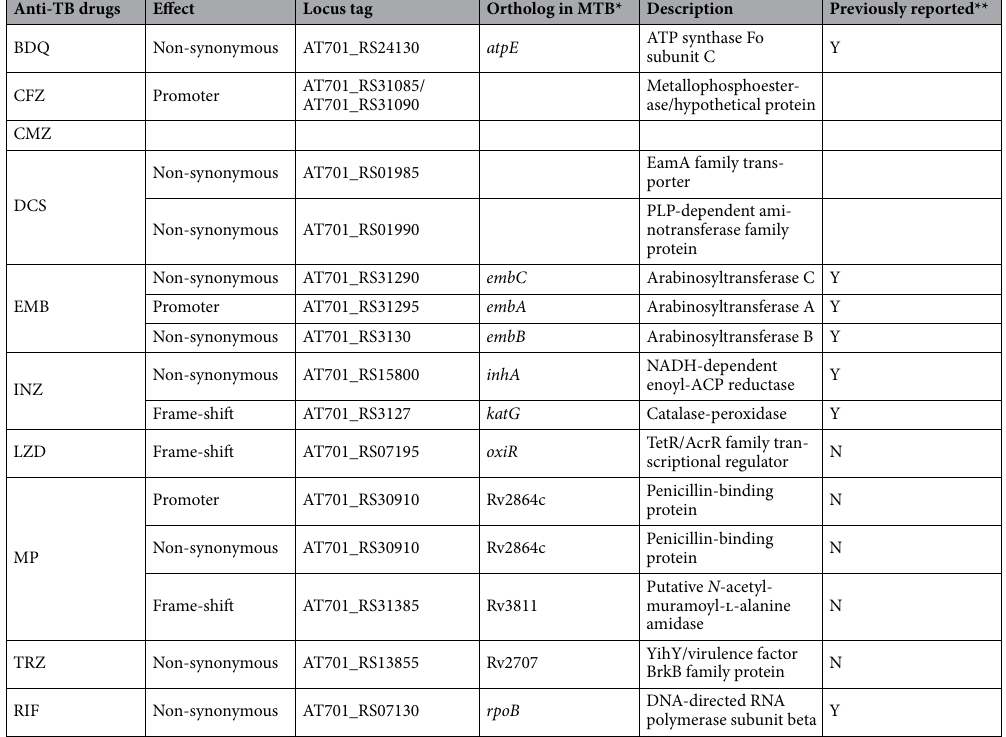
Table 2. Representative mutations that were commonly fixed in the evolved strains. *Orthlog genes in M. tuberculosis H37Rv strain are shown. **Genomic mutations of M. tuberculosis associated with drug resistance are indicated as Y (others are indicated as N) based on the previous report (Lange et al. 7